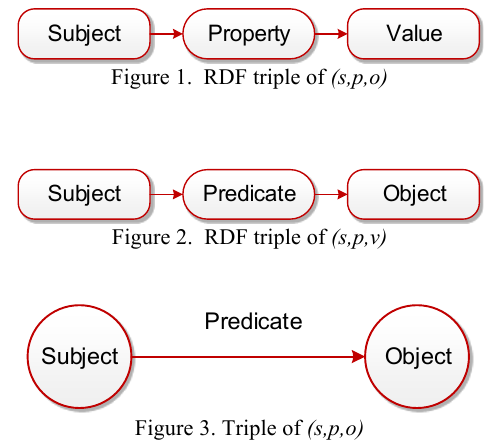
Figure 3. Triple of (s,p,o)